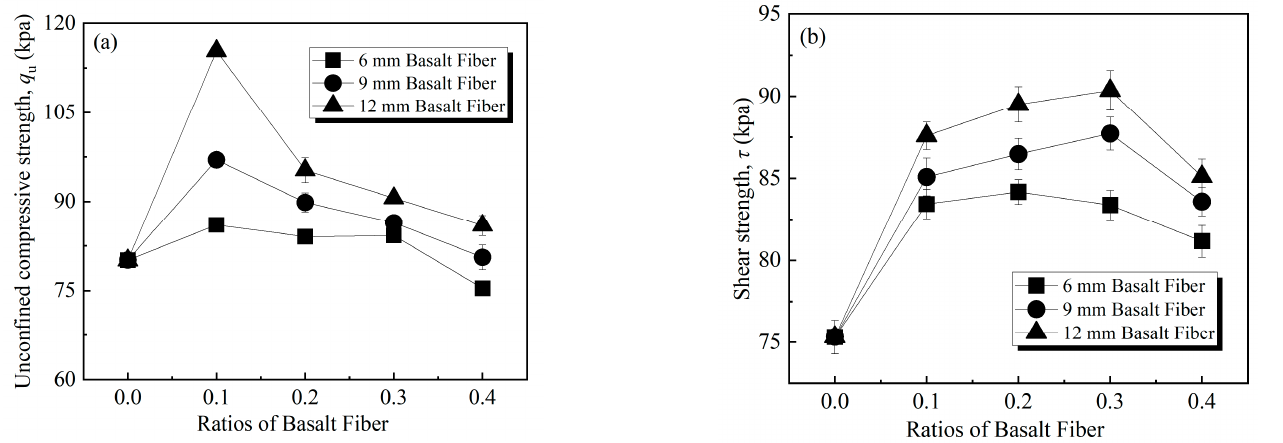
Figure 4. Variations of ( a ) unconfined compressive strength ( q u ) and ( b ) shear strength ( τ ) with different lengths and ratios of basalt fiber.